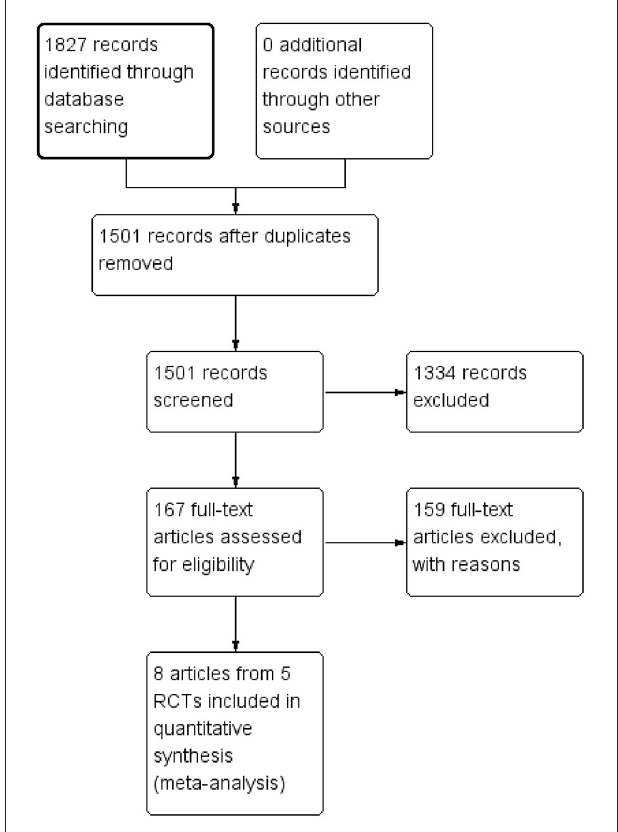
FIGURE 1 | The flow chart of study